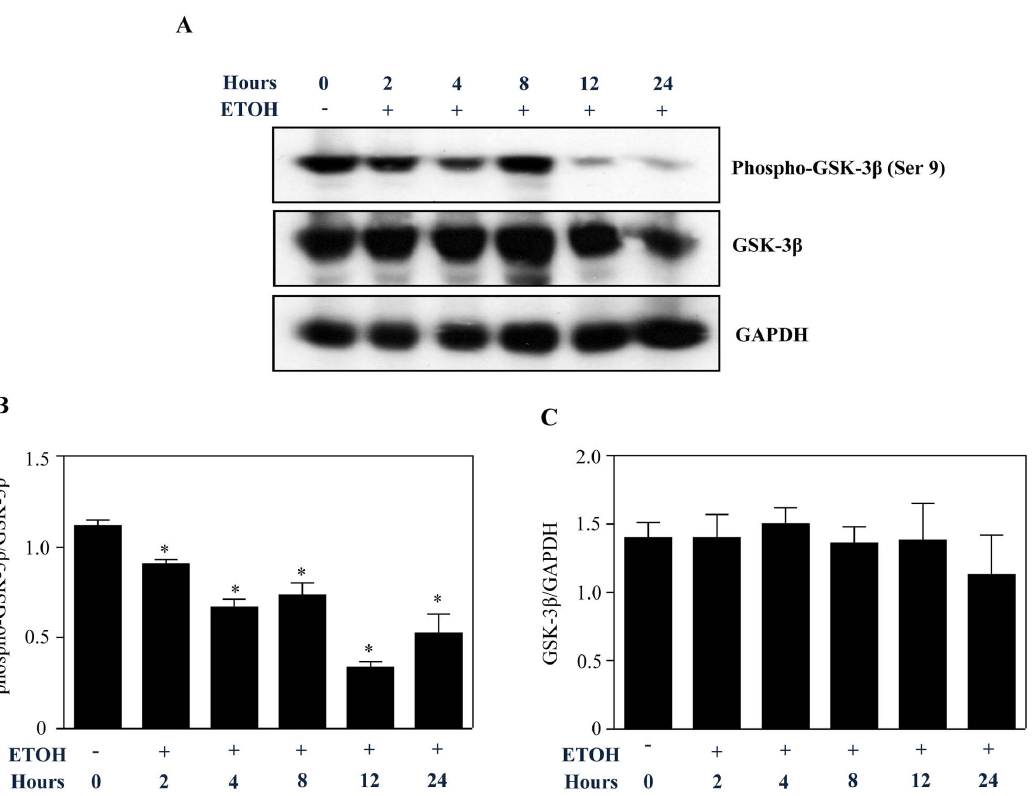
Figure 5. Ethanol activates GSK-3 b . Neuroblasts were treated with ETOH for 2, 4, 8, 12 and 24 h. Protein levels of phospho-GSK-3 b (Ser 9) were determined in control and ETOH treated cells by Western blot analysis (top). Statistical significance was evaluated by normalizing with GSK-3 b and GAPDH (bottom). Analysis was performed using one-way ANOVA followed by Newman-Keul’s posthoc test. *denotes p , 0.05 compared with control.